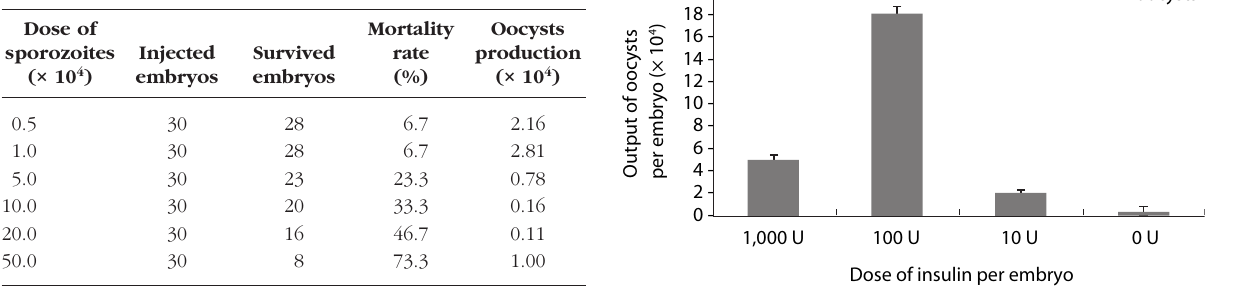
Table II. – Influence of the number of sporozoites inoculated per embryo.